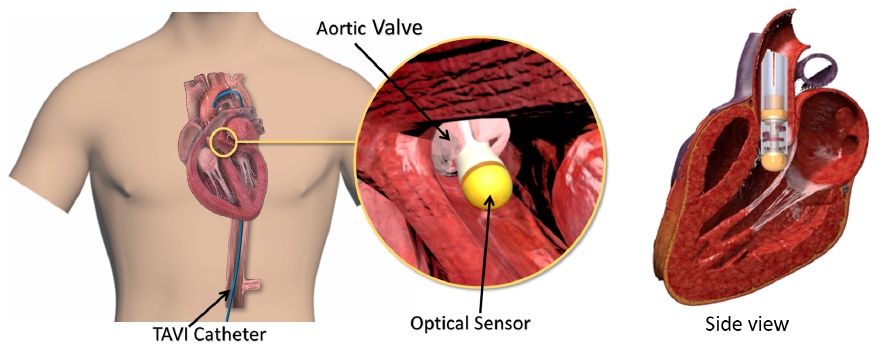
Figure 1. Schematic use case of the proposed sensor for aortic valve localization (the figure is not to